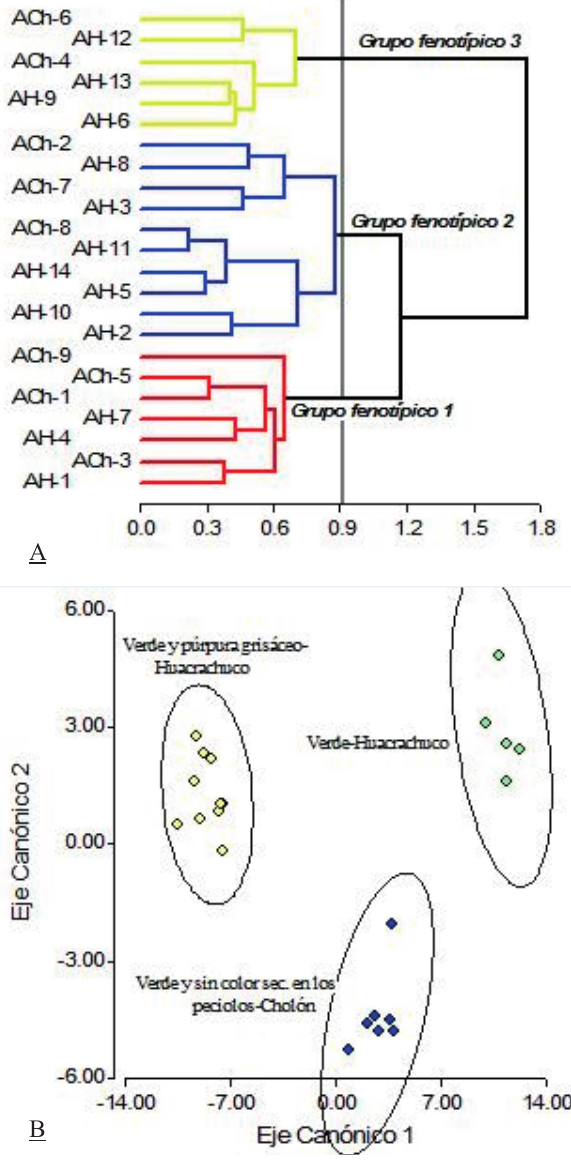
Figure 3. Dendogram (Ward method, Gower distance) (A) and prediction ellipses (B) for the phenotypic classification of 23 arracacha samples (A. xanthorrhiza ) grown in the province of